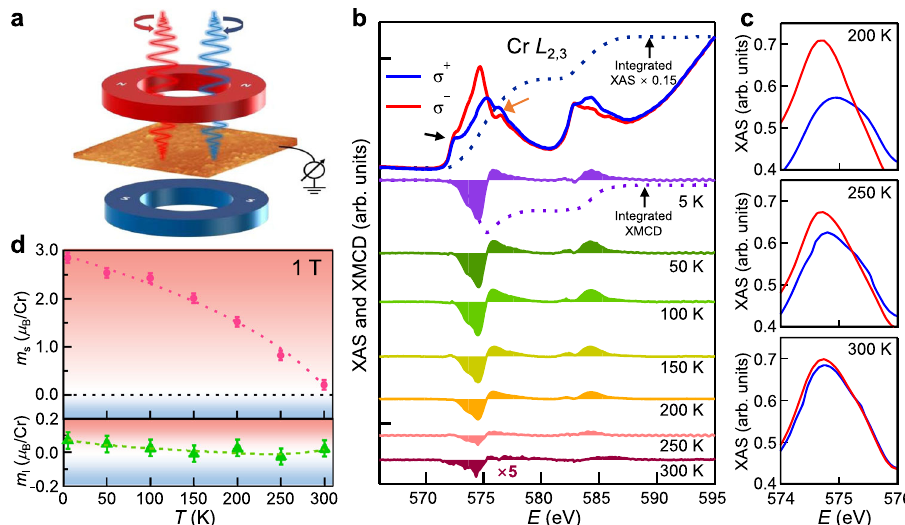
Fig. 3 XAS and XMCD characterization of 7 ML CrTe 2 fi lms. a Schematic geometry of XMCD experimental setup. b Typical pairs of XAS and XMCD spectra of 7 ML CrTe 2 from 5 K to 300 K and the integrals at 5 K, where the dichroism at Cr L 3 edge can be traced to 300 K (spectra at different temperatures are offset for clarify). c The partially enlarged XAS of Cr L 3 edge at 200 K, 250 K, and 300 K. d m s and m l versus temperature derived from ( b ) using sum rules. The error bars re fl ect the uncertainties in the background estimation for the XMCD sum rules